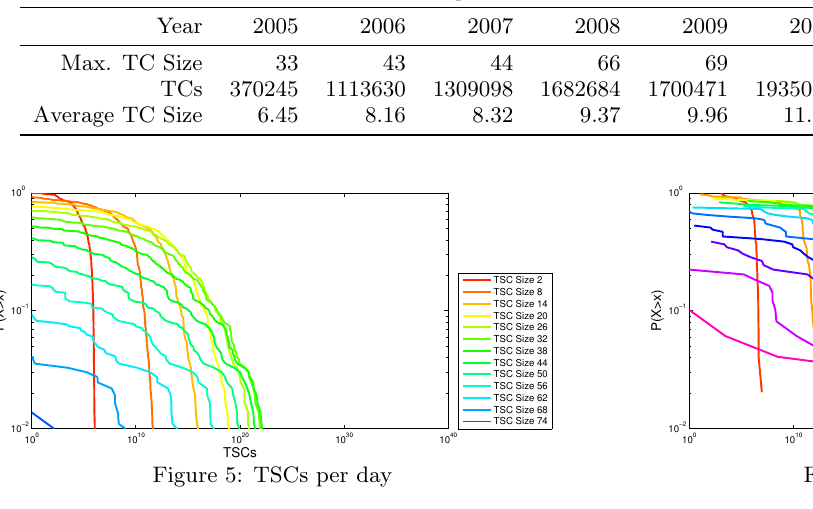
Table 1: Temporal communities observed in the dataset